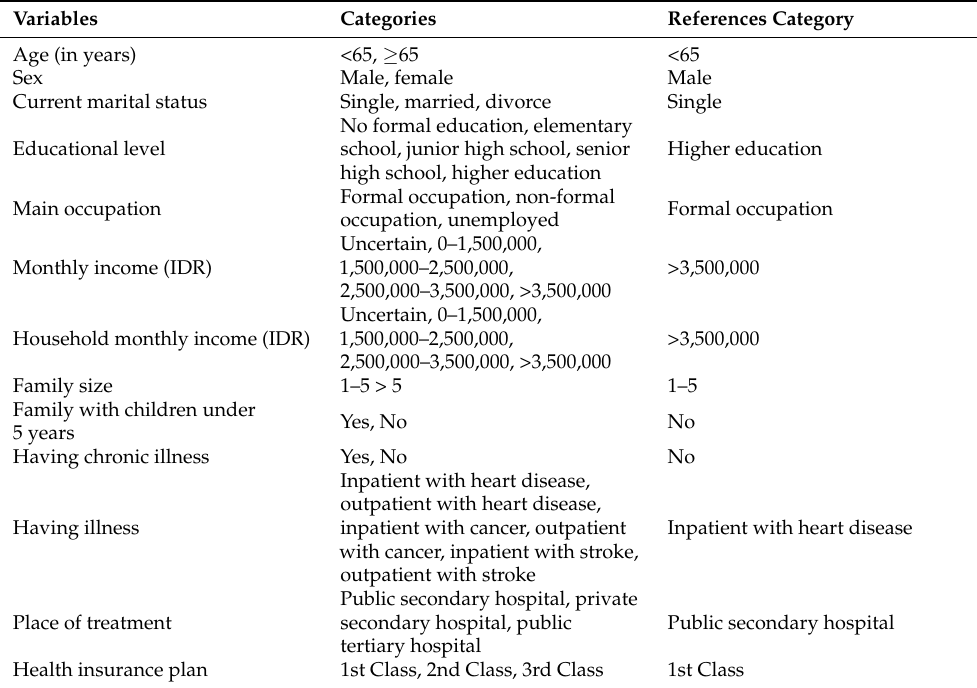
Table 1. Variables in logistic regression of factors associated with willingness to pay for